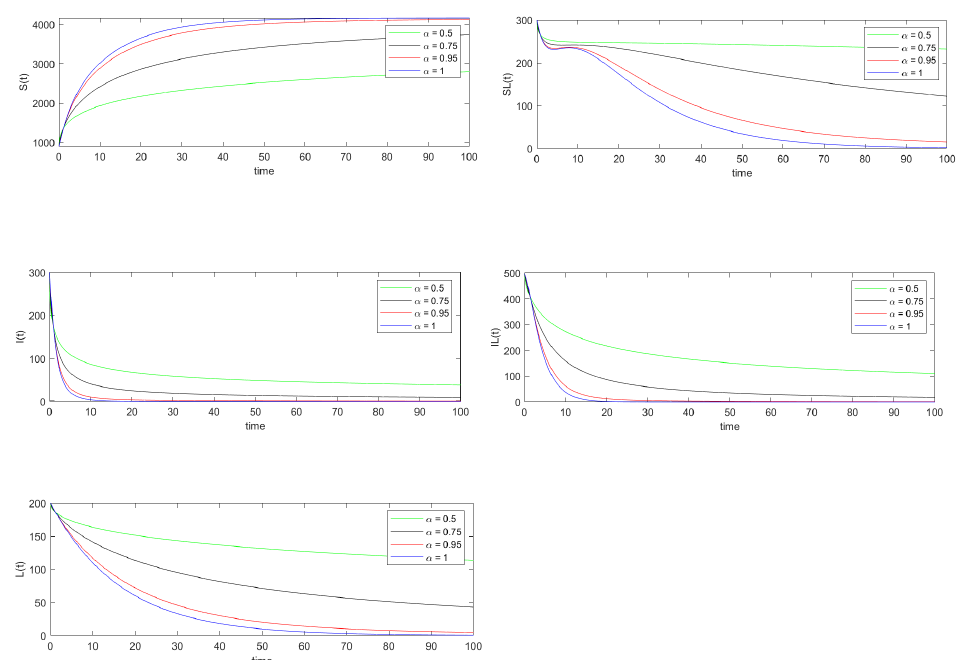
Figure 1. Numerical simulation of the trajectories of the solution of system (8) when R 0 < 1.